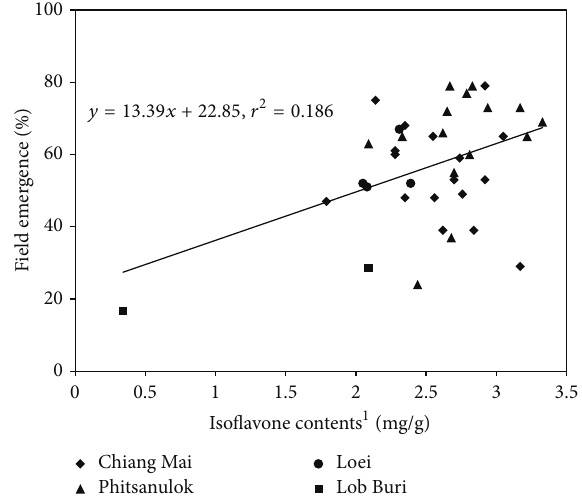
Figure 8: The coefficient of determination value ( 𝑟 2 ) calculated by linear regression analysis between percentages of seed field emer- gence and total isoflavone content in sound seeds of Chiangmai 60 soybean variety grown in dry season crop year 2010 ( 𝑛 = 38 different lots) and obtained from 4 agricultural research centers in Thailand. Each lot was extracted and assayed in triplicate. 1 Isoflavone content was the summation of daidzin and genistin